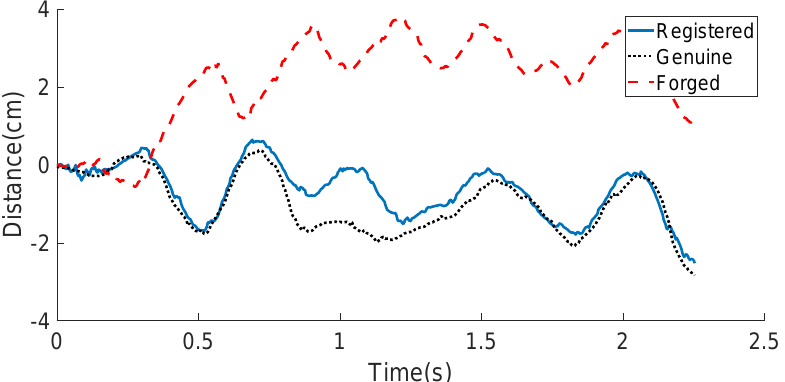
Figure 9. User’s bottom microphone displacement example: registered, genuine, and forged in- air